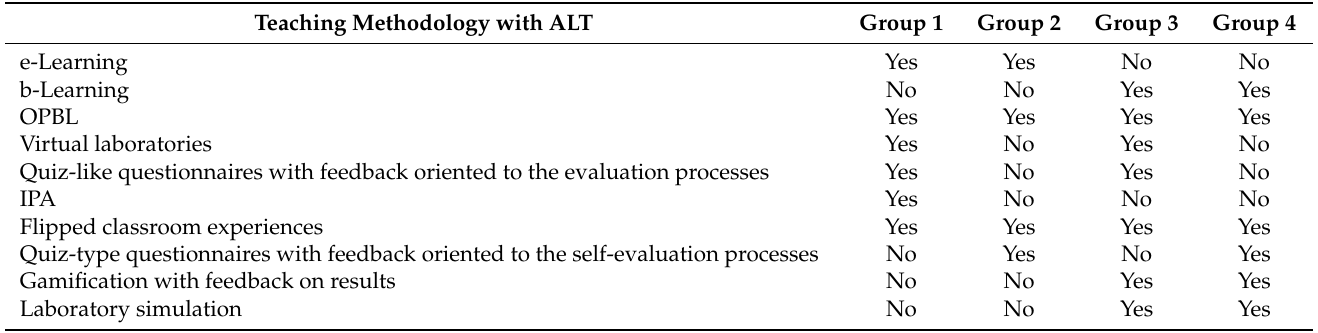
Table 3. Teaching methodology applied in the intervention